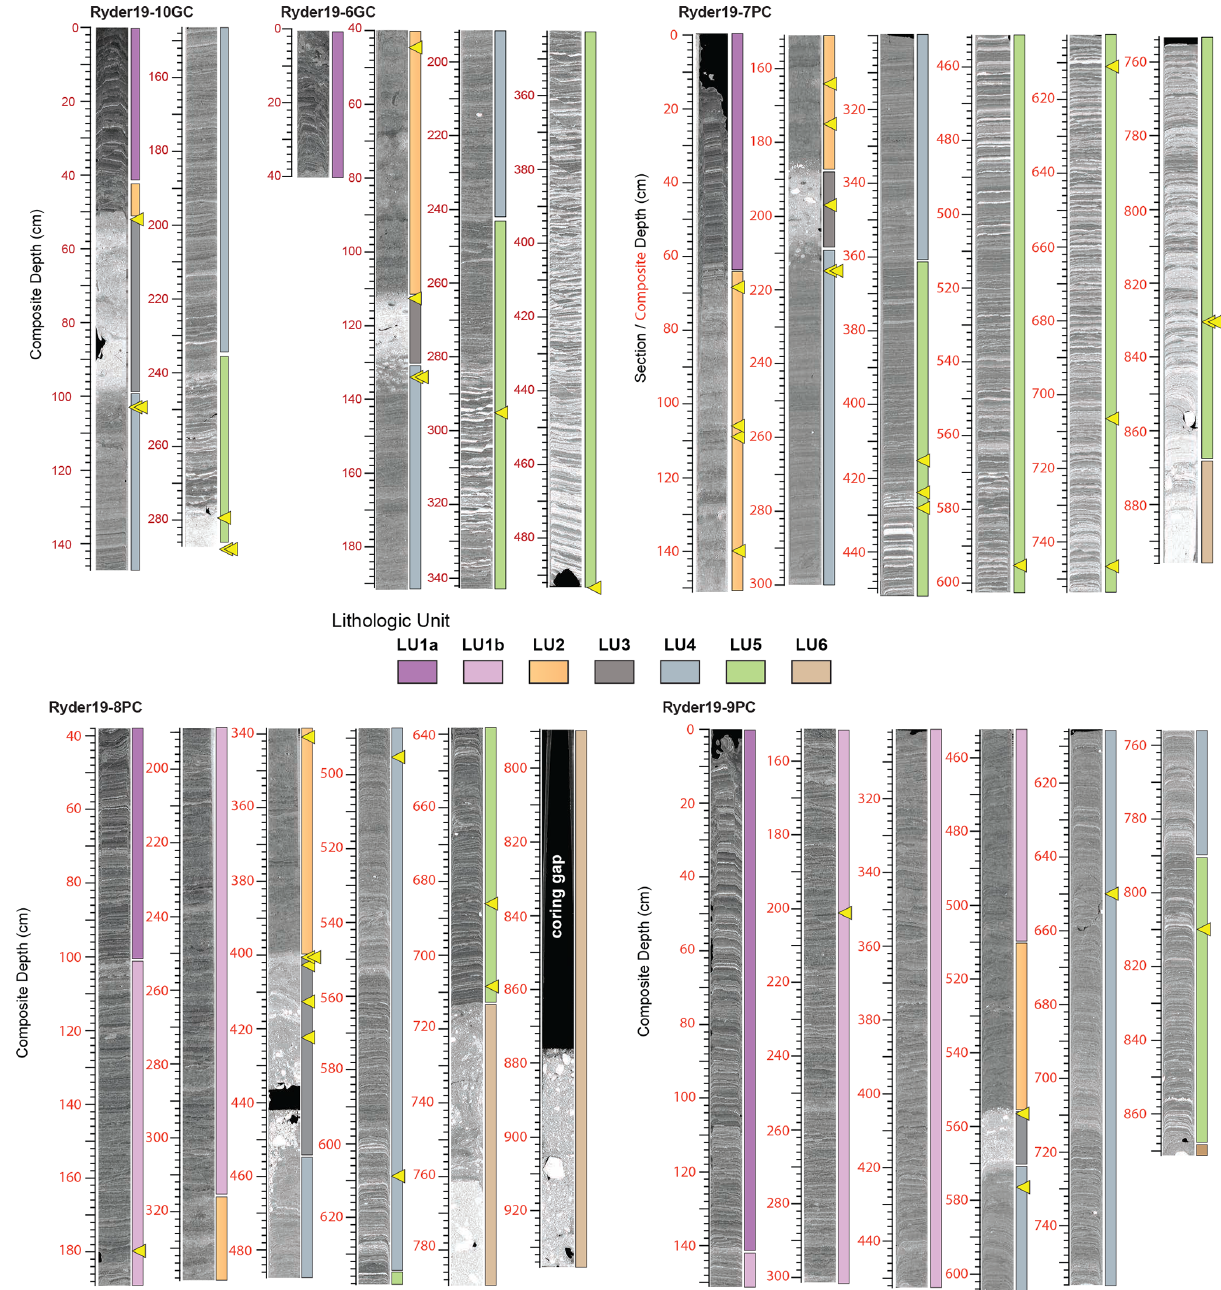
Figure 6. CT images and associated lithologic units for each core. White in CT images corresponds to higher density zones and black to lower density zones. Yellow triangles represent levels of radiocarbon dates. Larger images showing section depths and composite depths are provided in Figs.